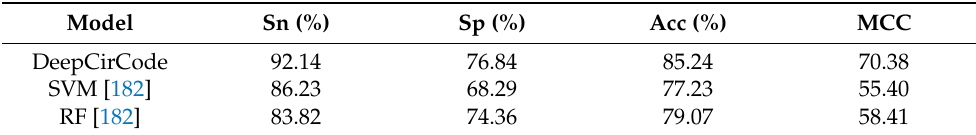
Table 9. Performance comparison of DeepCircCode with two models developed previously by the authors.